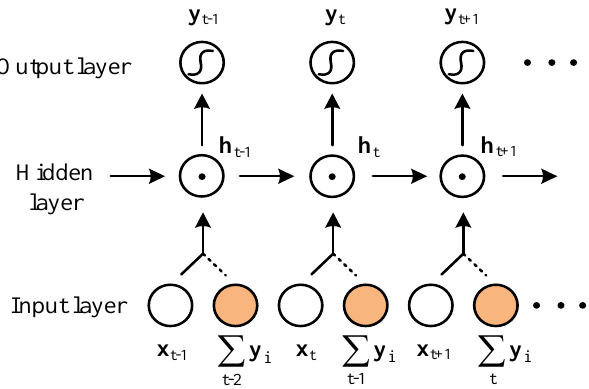
Figure 5. Structure of IRRNN model unfolded by time.